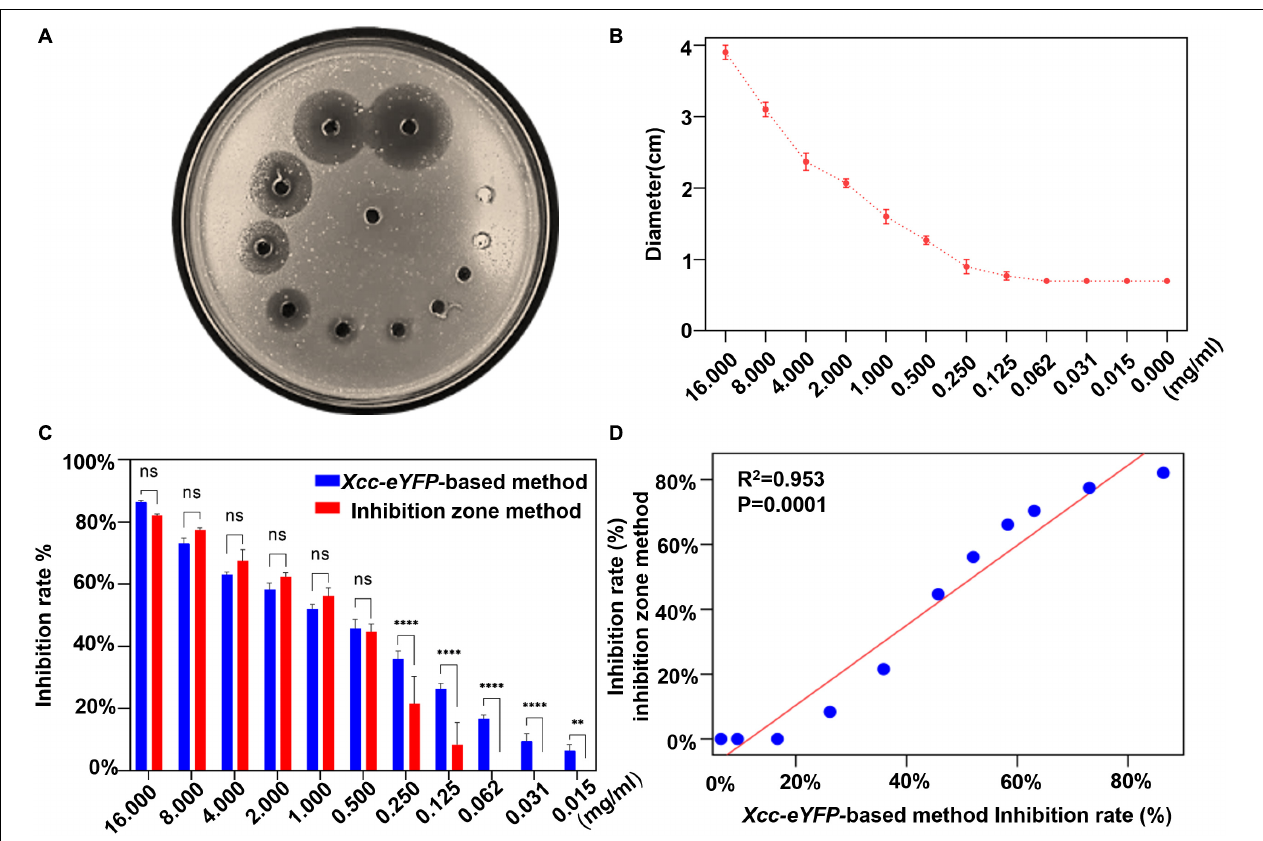
FIGURE 2 | Comparison of bactericidal inhibition rates between reporter-based and conventional inhibition zone methods. (A) The image of inhibition zones on an Xcc-eYFP plate treated with different 11 concentrations of 30% copper oxychloride (SC) by the inhibition zone method. (B) The inhibition zone diameters were caused by 11 concentrations of 30% copper oxychloride (SC) and the control group. Means and SDs of three replicates of a representative result are shown. The vertical bars represent the SD of the means. (C) The accuracy comparison between the reporter-based assay and the inhibition zone method to calculate the inhibition rate at a series of 30% copper oxychloride (SC) concentrations. Means and SDs of three replicates of a representative result are shown. Statistical analysis was processed by two-way ANOVA following multiple comparisons with the Tukey’s test (95% CI) using GraphPad Prism 9 (** p < 0.05, **** p < 0.0001, and ns >